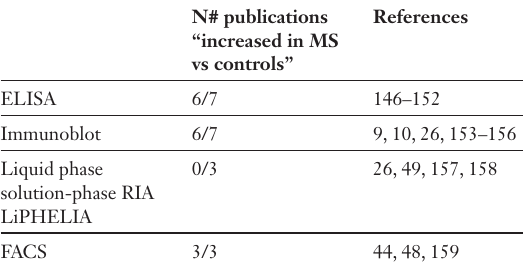
Anti-MOG Abs stud- ies classified accord- ing to the technique of